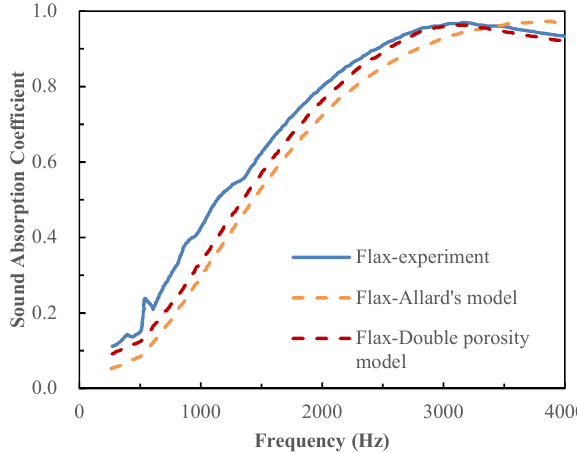
Figure 7. Comparison of experimental and theoretical sound absorption coefficients of unidirectional flax fiber fabrics with frequency.